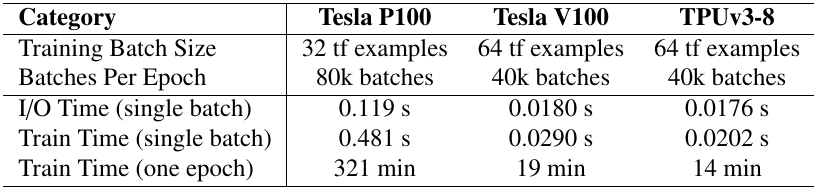
Table 4. I / O and training time comparison for di ff erent